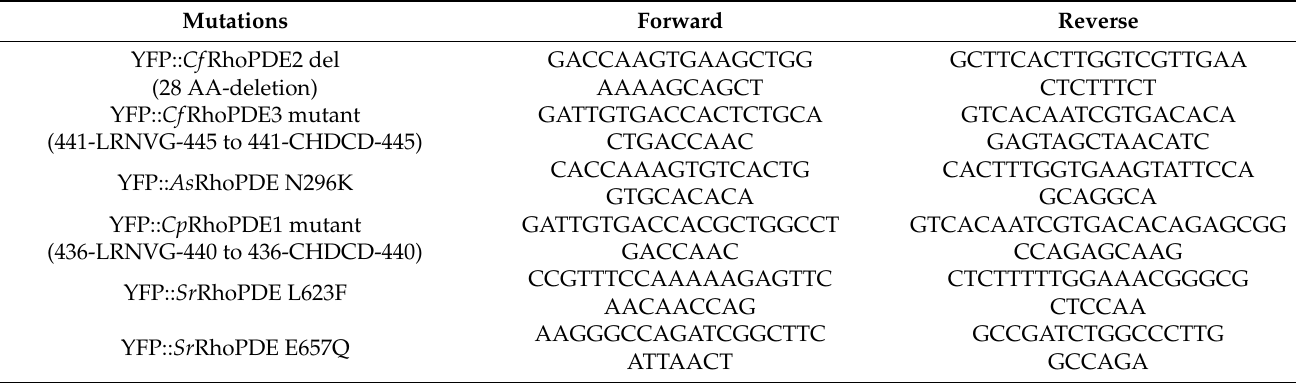
Table 1. List of primer sequences in 5 (cid:48) -3 (cid:48) orientation.